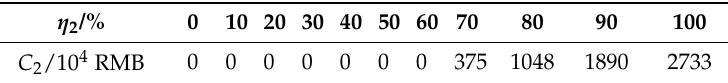
Table 7. Values of C 2 under different subsidies.